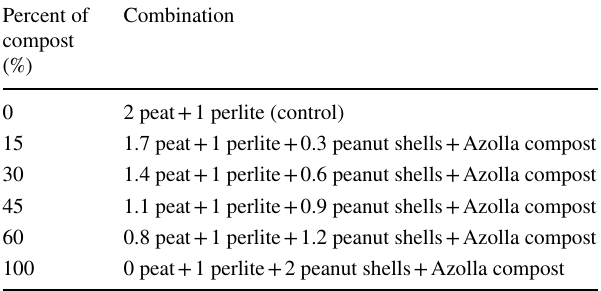
Table 1 Composition of the growing media Percent of compost